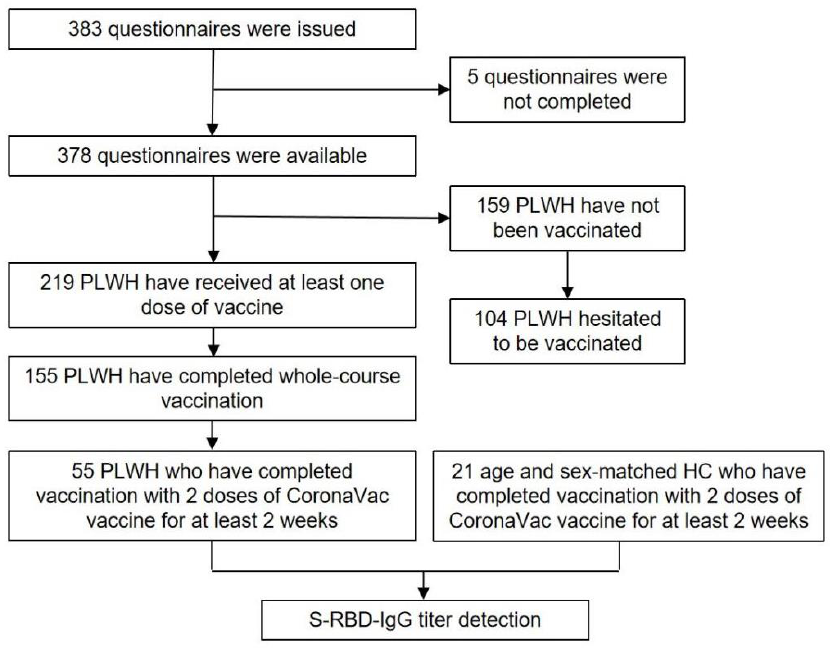
Figure 1. Flowchart of participants inclusion. PLWH: people living with HIV; HC: health control; S-RBD-IgG: spike receptor binding domain-protein specific IgG.